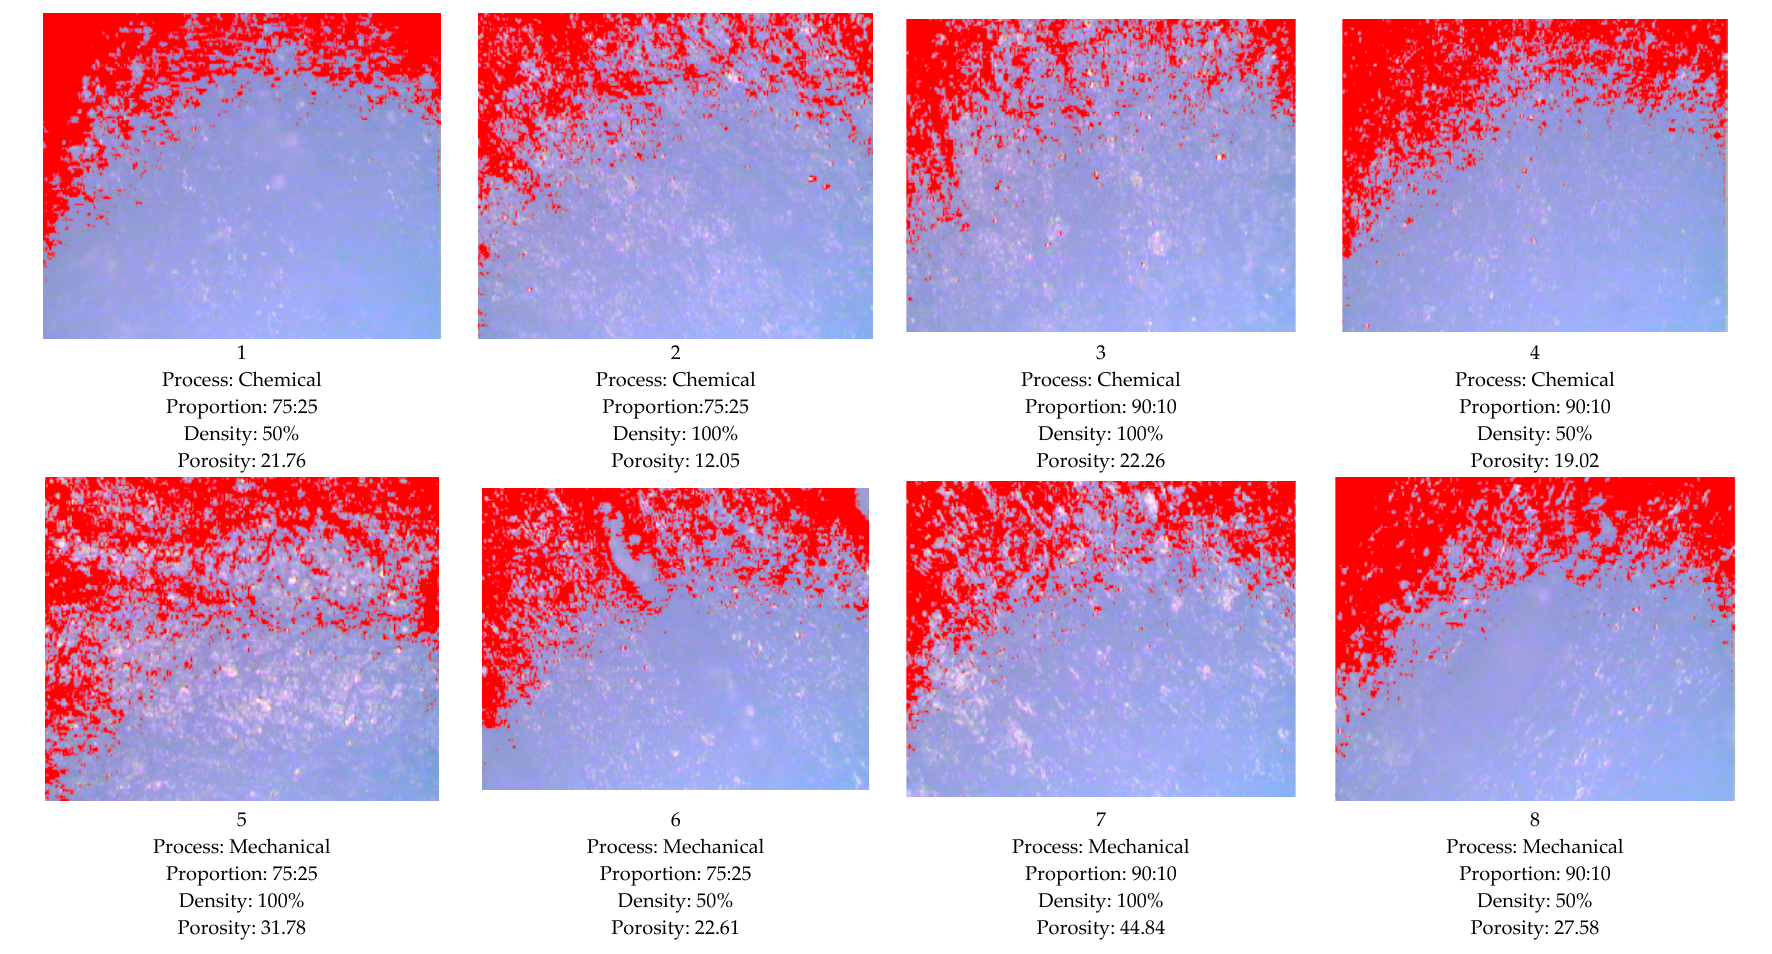
Figure 8. Optical micrographs for ABS–Gr chemically and mechanically blended samples (100×).